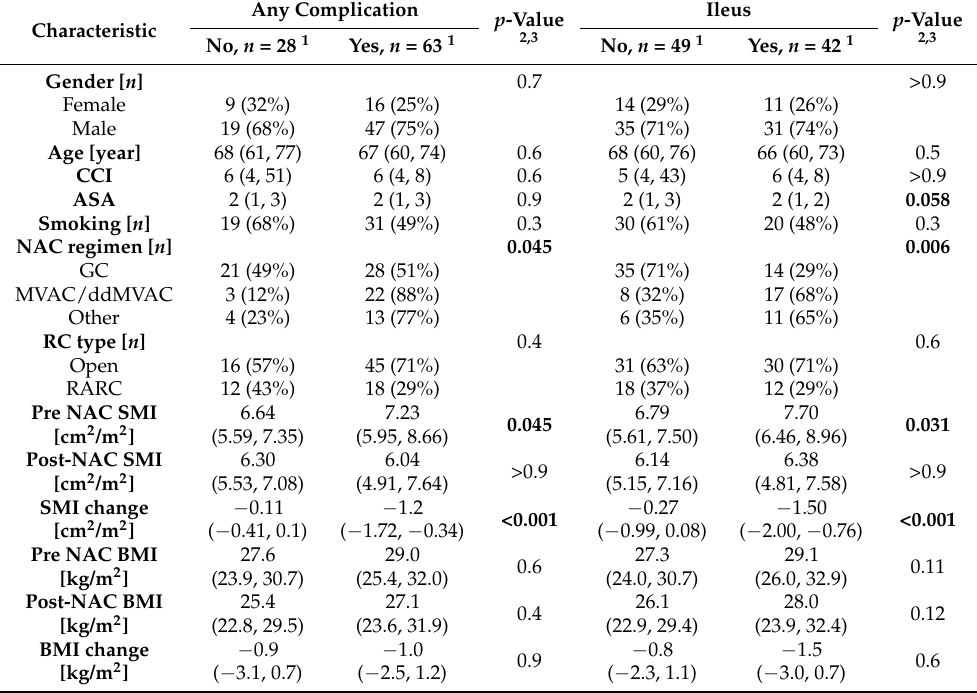
Table 2. Descriptive statistics according to all complications and ileus.